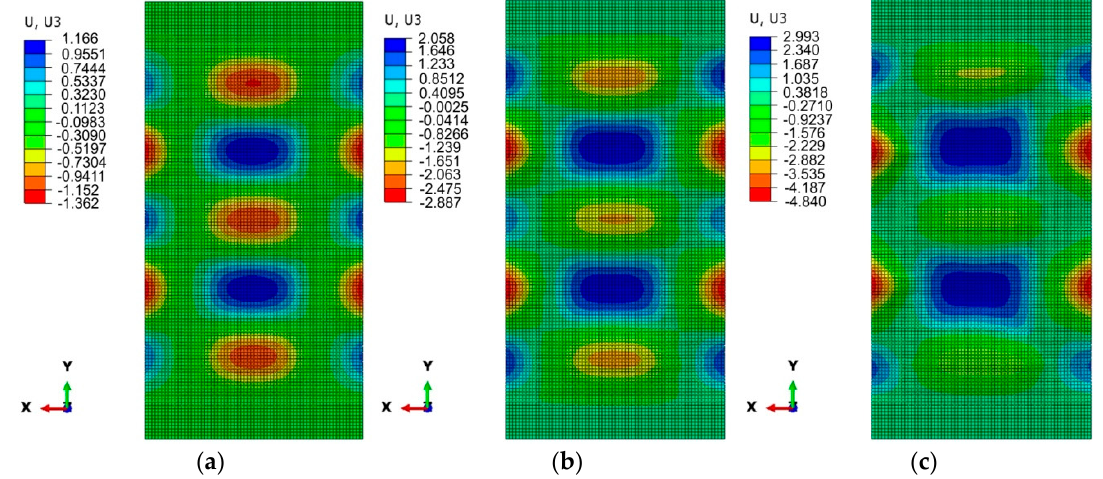
Figure 8. Deformation of a sti ff ened panel with riveted stringers in a postcritical state ( s = 23.5 mm) when subjected to a compressive force of: 0.25 F max ( a ), 0.5 F max ( b ) and 0.75 F max ( c ).